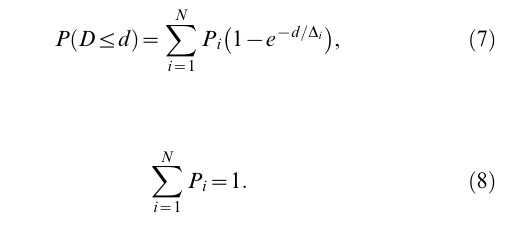
Cluster Valence k on